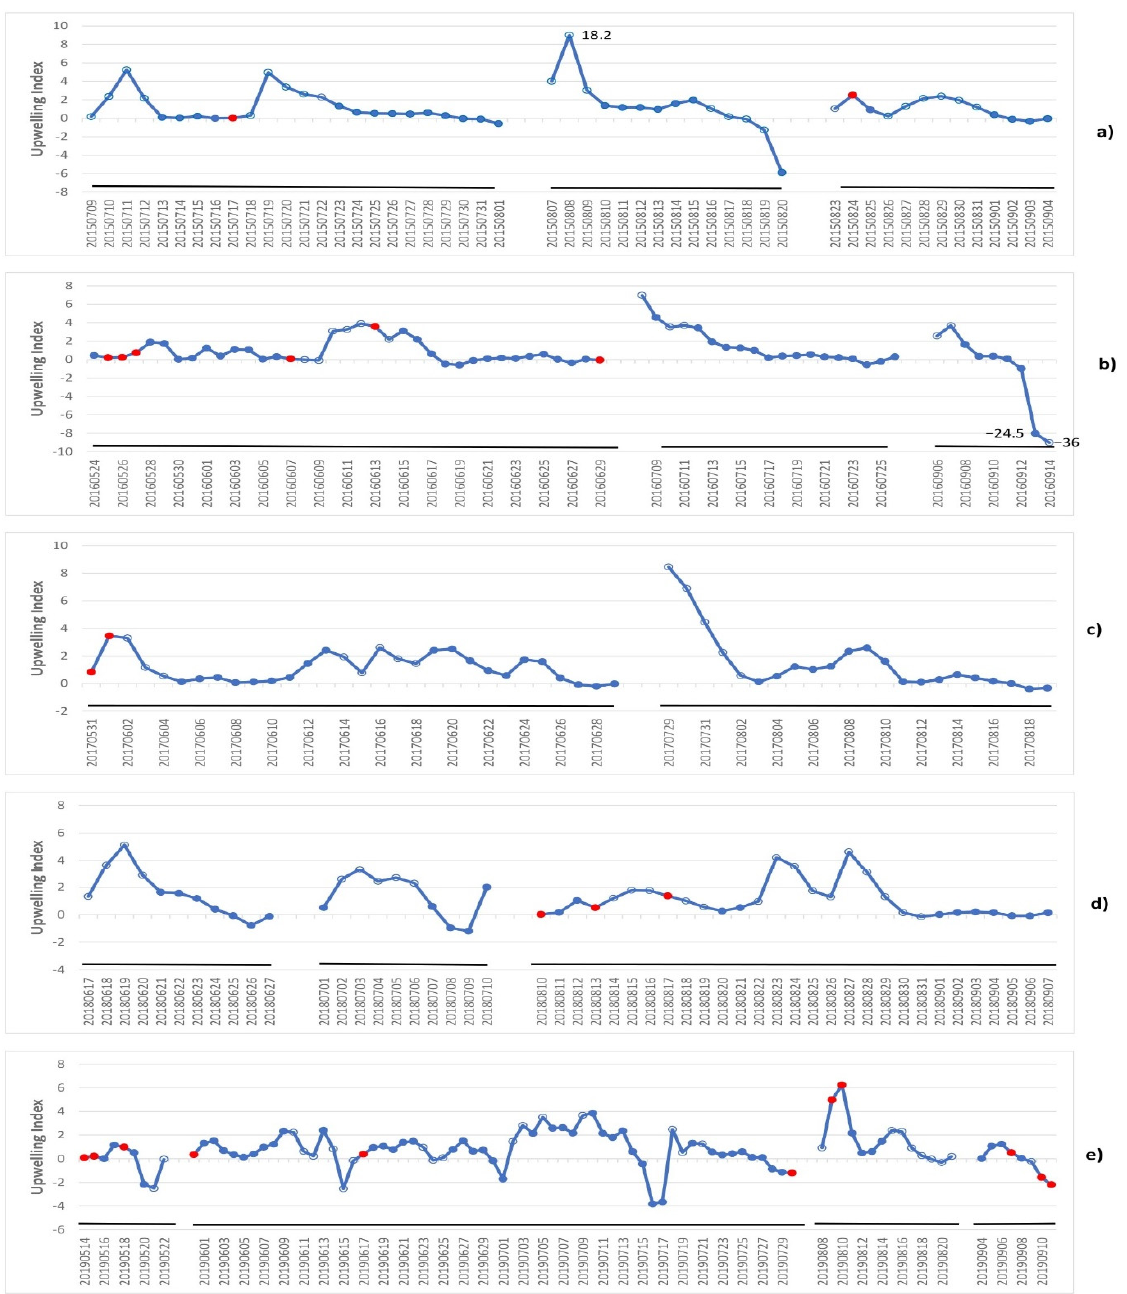
Figure 5. Time-series of the significant upwelling-favorable wind events at the southern location; ( a ) 2015, ( b ) 2016, ( c ) 2017, ( d ) 2018, ( e ) 2019. Symbols as Figure 3. The labelled value(s) are actual UI value(s) that could not be properly